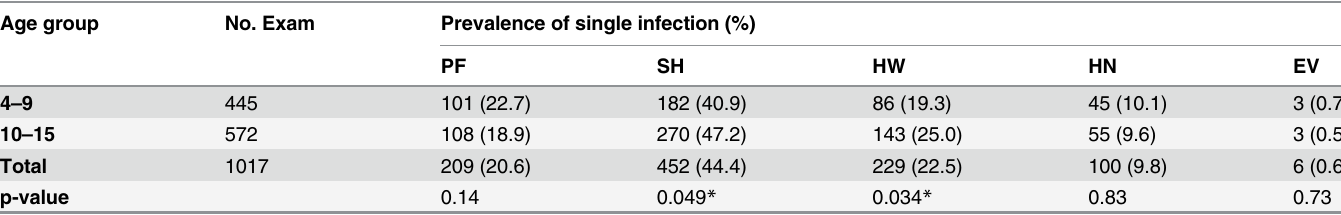
Table 2. Prevalence of single parasitic infection among children by